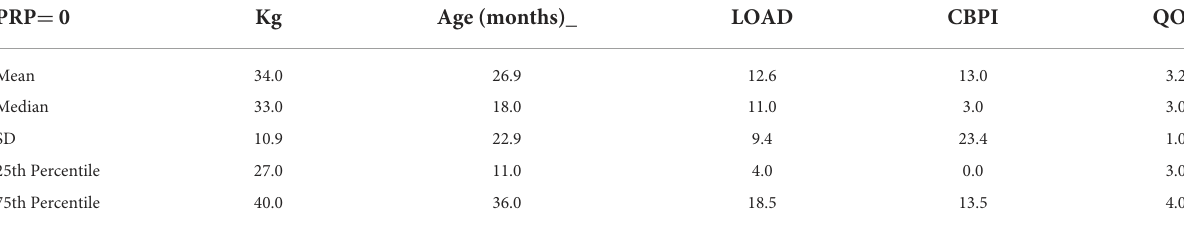
TABLE 2 Summary for arthroscopy alone